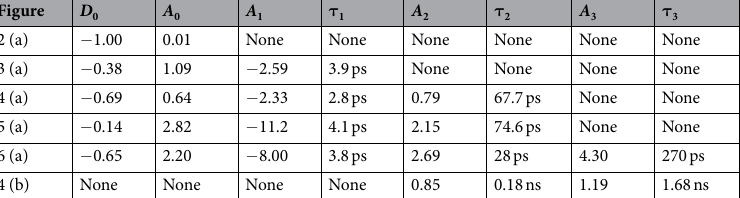
Because TPA can be treated as an instantaneous process, the Gaussian-like function at zero time delay in in Eq. (1) and the cross-correlation function of the optical pump and Fig. 2(a) is actually the convolution of δ D t ( ) 0 probe pulses C t ( ) 31, 36 . Note that the TPA, centered at zero time delay, was simultaneously contributed by each photon from the pump and probe pulses 31 . TPA only occurs when the pump pulse is temporally overlapped with the probe pulse, leading to reduction of the transmitted probe intensity. The red dashed line shows the fitting curve in Fig. 2(a). The parameters of the response function are summarized in Table 1. In addition to δ D t ( ) for 0 TPA process, a small value of A 0 , corresponding to a slow process within the observation window, was used for fitting. Since the signal is comparable to the noise level, carrier dynamics of un-doped GaN as illustrated in Fig. 2(b) will not be further discussed under this experimental condition. Figure 3(a) shows the transient measurement of Mn-doped GaN with concentrations of 1.1 × 10 19 cm − 3 . In and δ D t ( ) was used to account for the instantaneous process of TPA. The 0 positive step function A U t ( ) 0